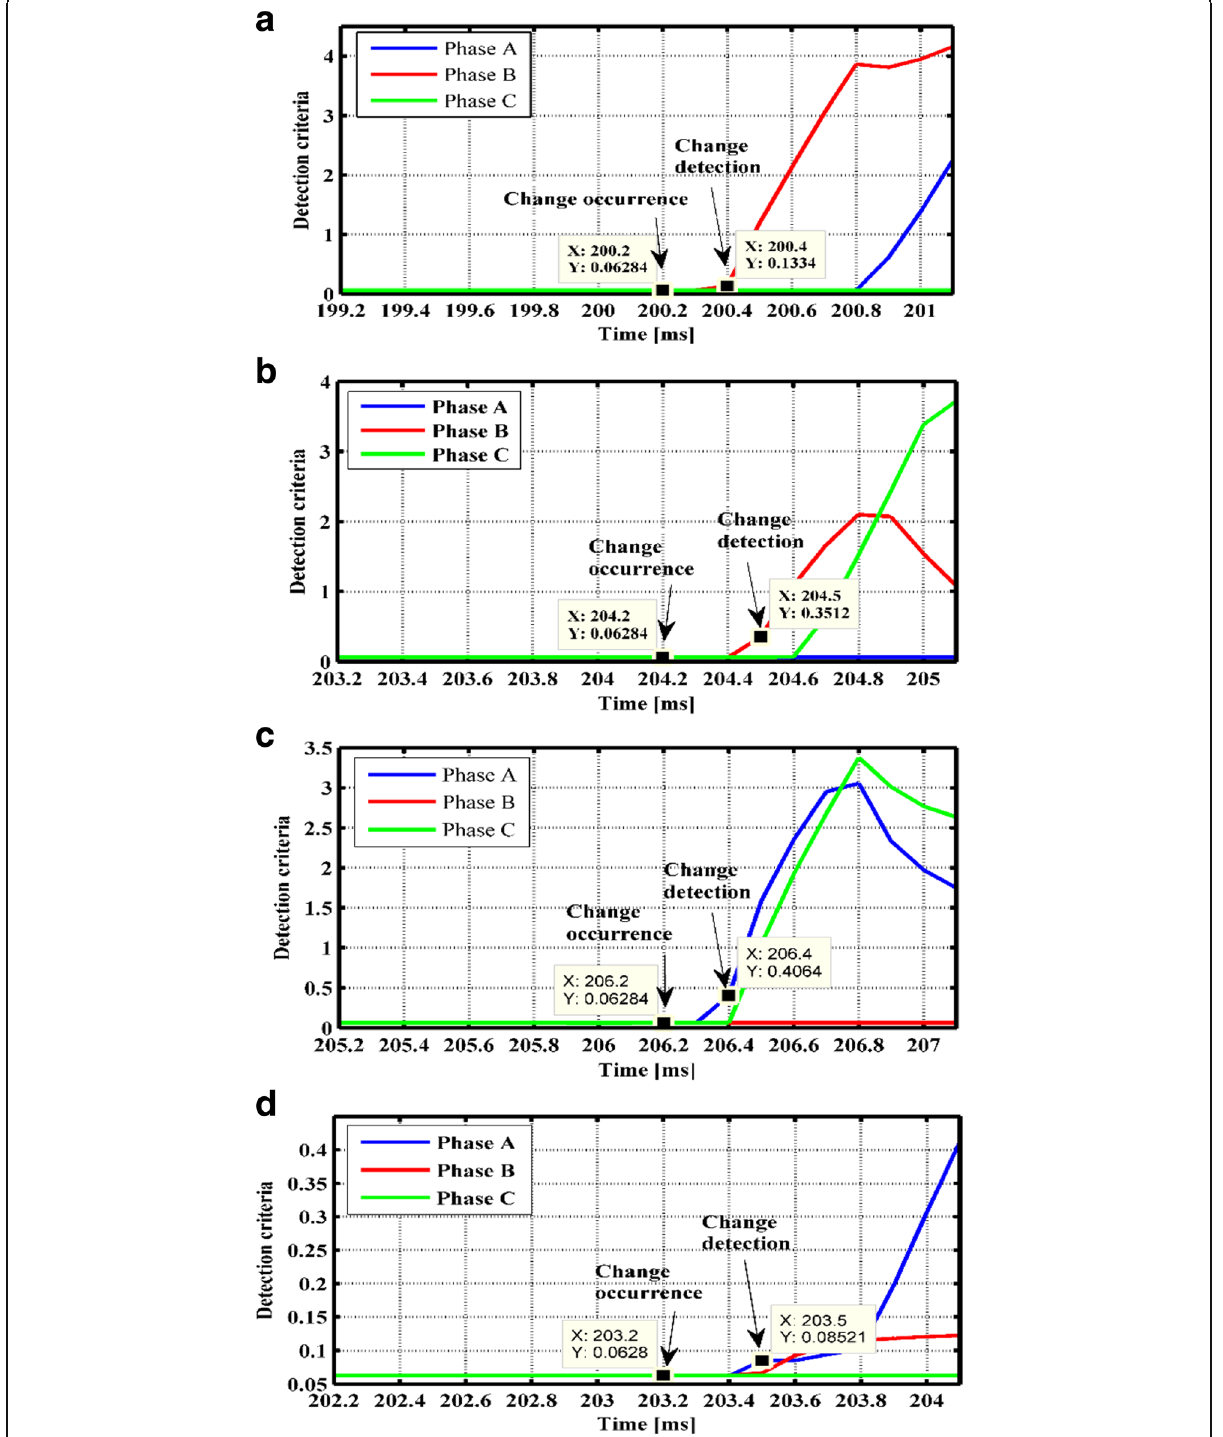
Fig. 3 The proposed criterion. a Fault AB, negligible resistance, t0 = 0.2002 s. b Fault BCg, R f = 10 Ω , t0 = 0.2042 s c Fault AC, R f = 40 Ω , t0 = 0.2062 s d Switching of load 200 MW, t0 = 0.2032